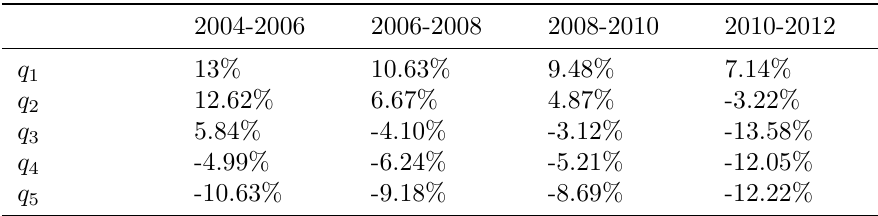
Normalized directional index for income